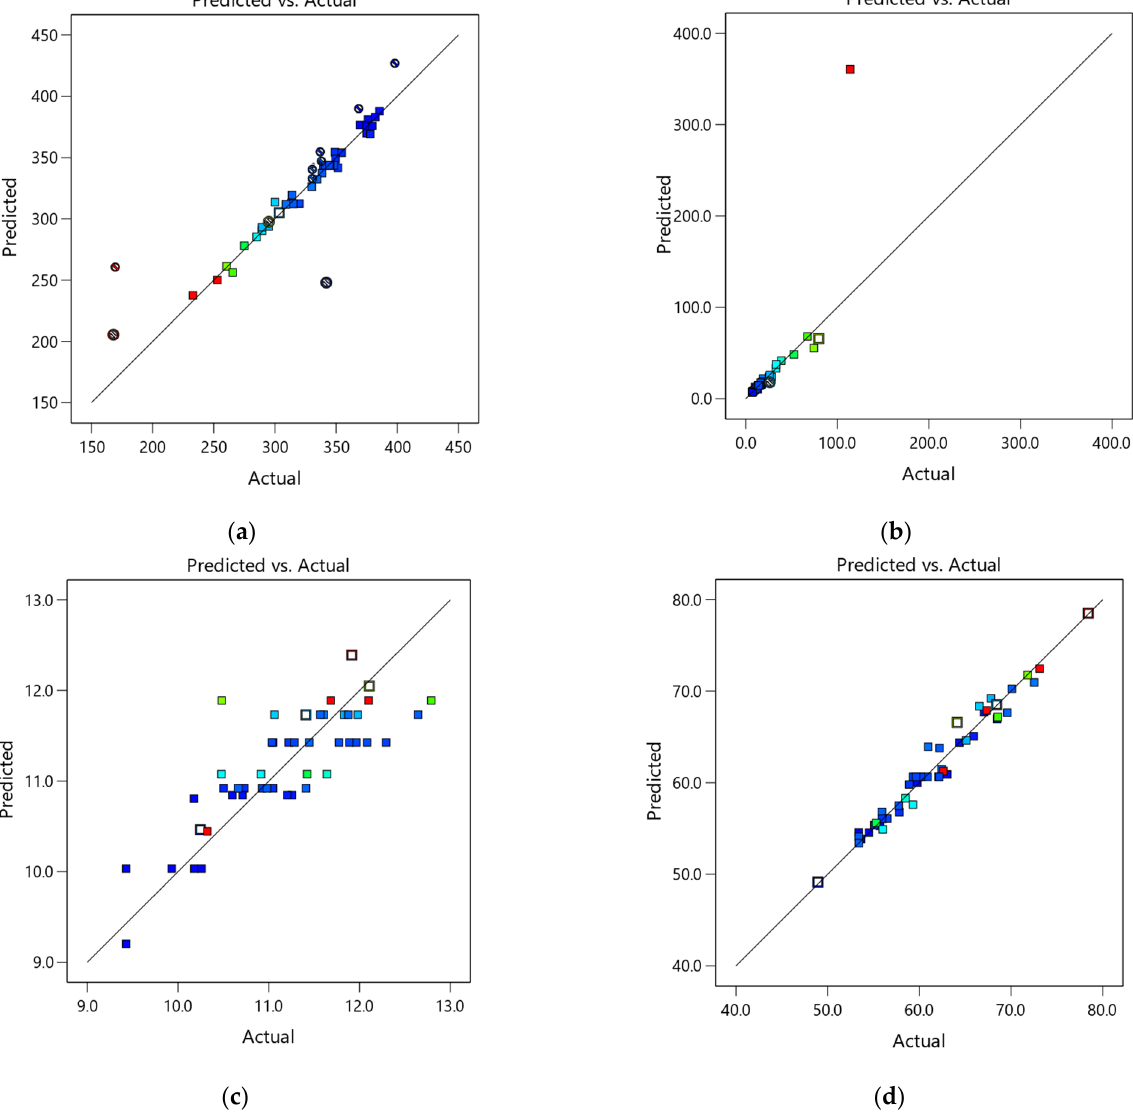
Figure 10. Predicted versus actual plan: ( a ) D-flow, ( b ) T-funnel, ( c ) F,24 h, and ( d ) Rc,24 h.